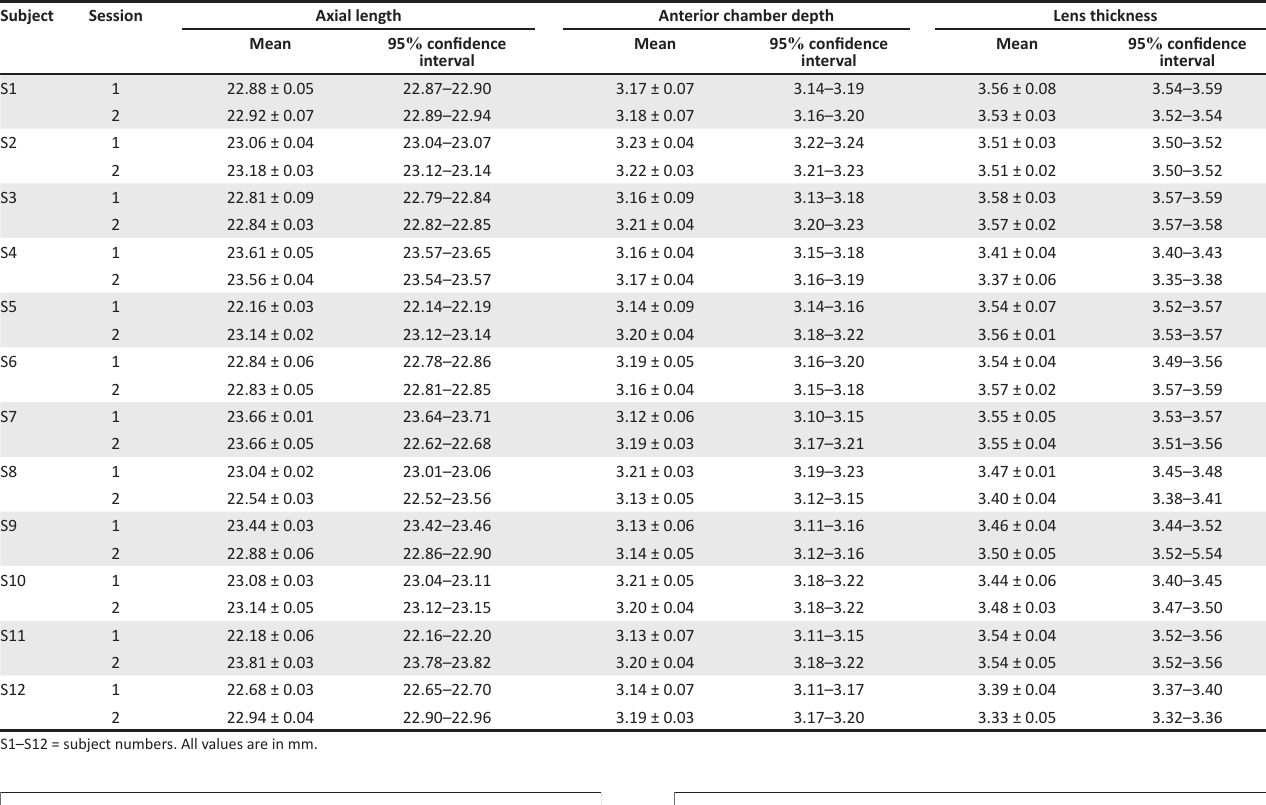
TABLE 1: Descriptive statistics for axial length, anterior chamber depth and lens thickness for each subject, performed in the first and second sessions.